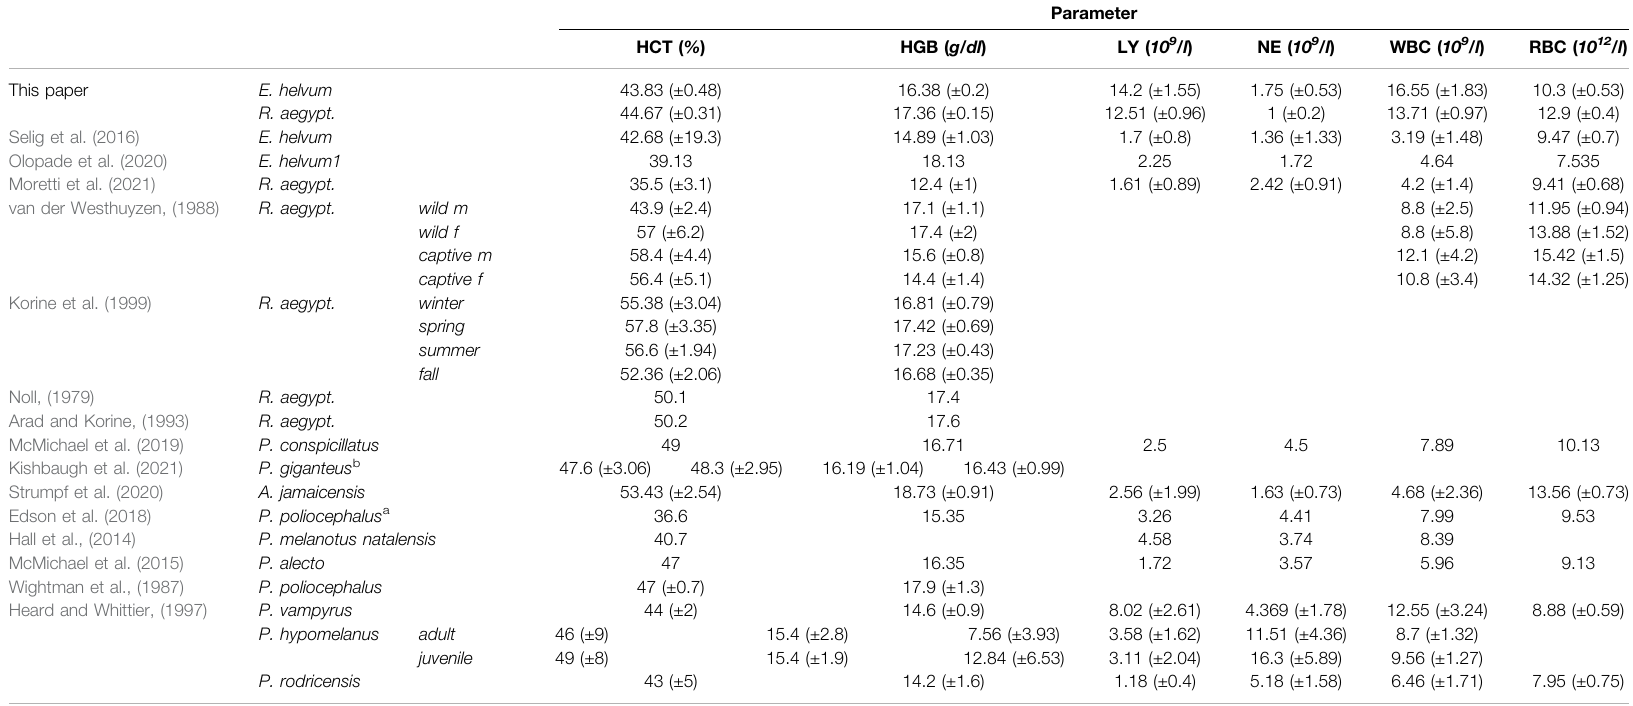
TABLE 4 | Comparative hematology values determined in pteropodid bat species.